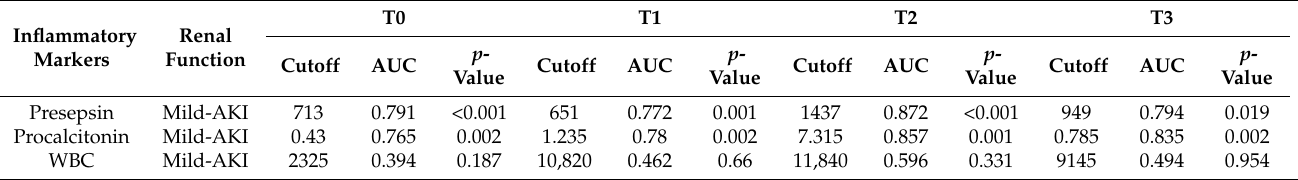
Table 9. Accuracy of inflammatory markers in predicting in-hospital mortality according to AKI severity, by period. Inflammatory Markers